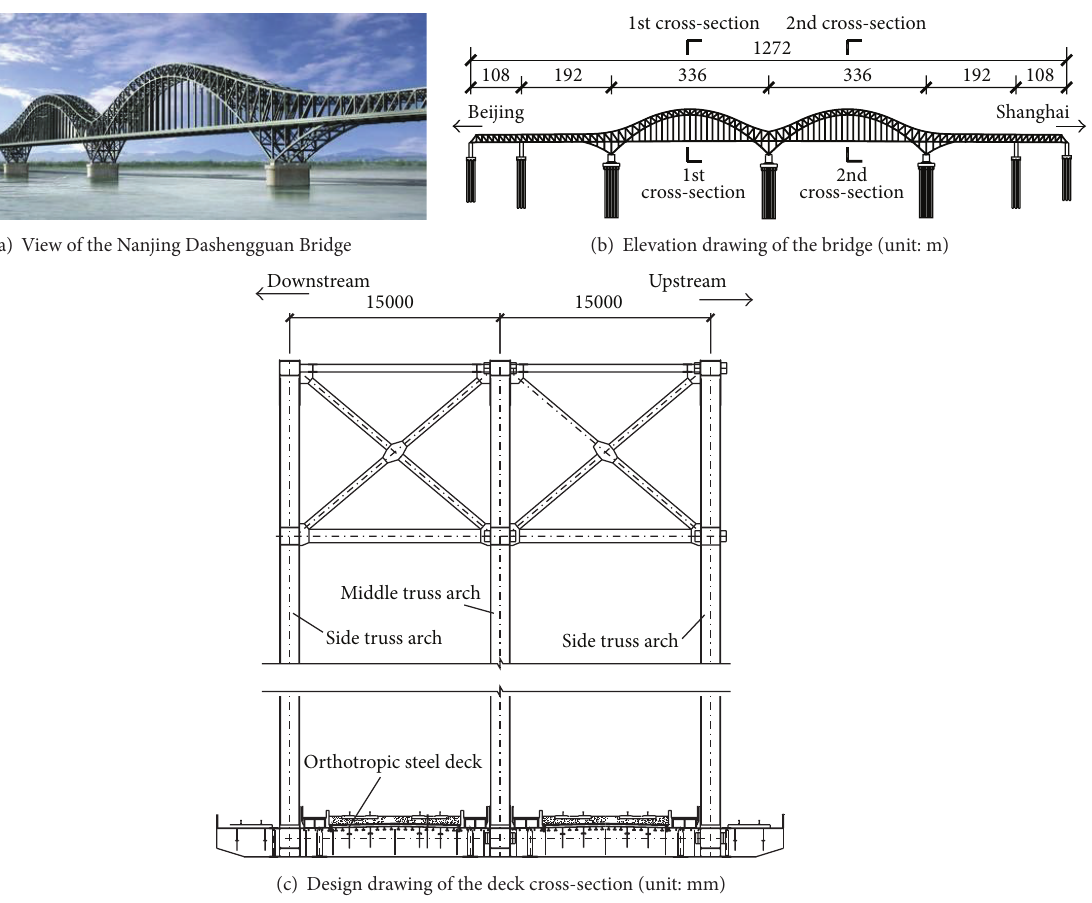
Figure 1: Nanjing Dashengguan